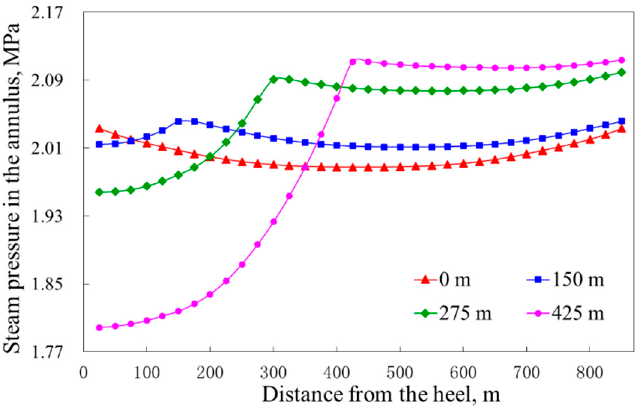
Figure 9. Effect of the injector wellbore configuration on the annulus pressure profiles of the injector.